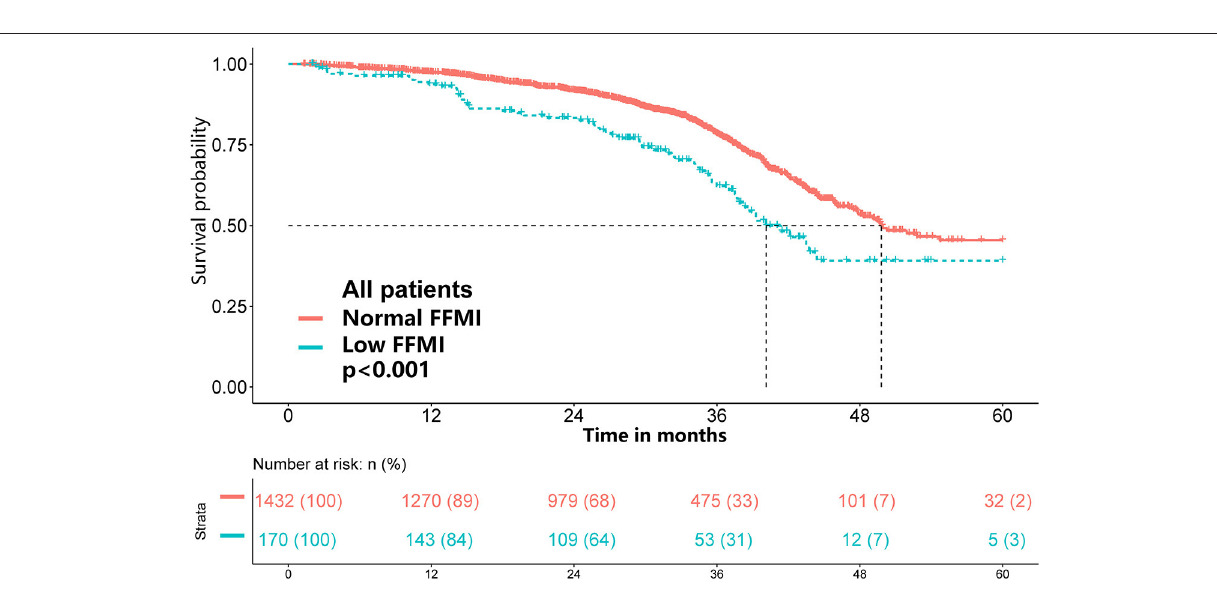
Frontiers in Nutrition |